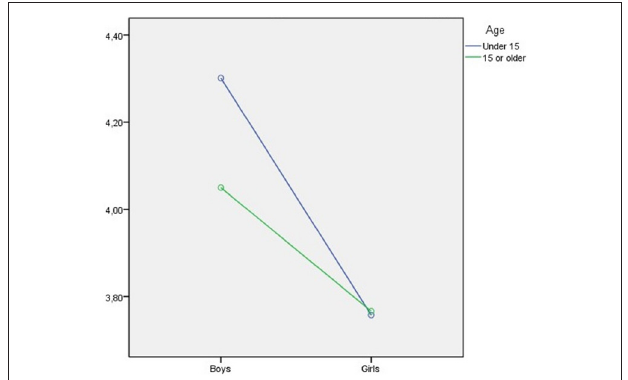
TABLE 6 | Percentiles of each of the ER